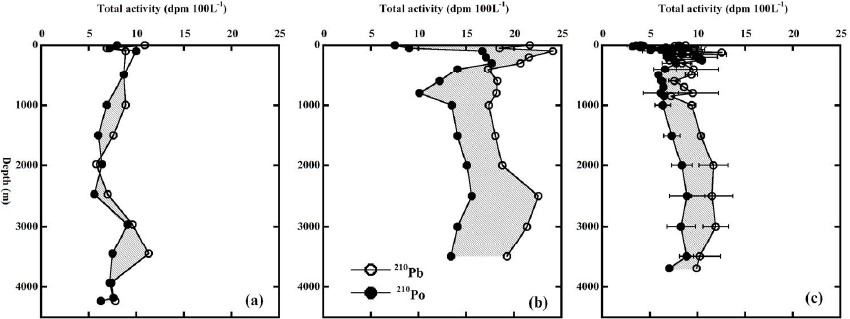
210 Po Fig. 3 Figure 3. Vertical profiles of 210 Pb t and t plotted from (a) the data reported at station PA-11 of Obata et al. (2004), (b) the average values of the two profiles at station C of Chung and Wu (2005), and (c) the average values with standard deviations measured by the four cruises of this study. Shaded area represents deficiency of 210 Po relative to 210 Pb.